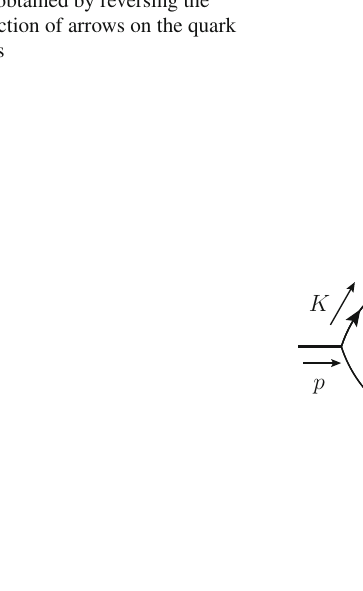
Fig. 3 Graphs for gluon-quark or gluon-antiquark DPDs corresponding to the gluon PDF graphs in Fig. 1. The loop momenta are defined in (19) and (20), and each graph is for the momentum fractions specified in (15)–(17). Four more graphs are obtained by reversing the direction of arrows on the quark